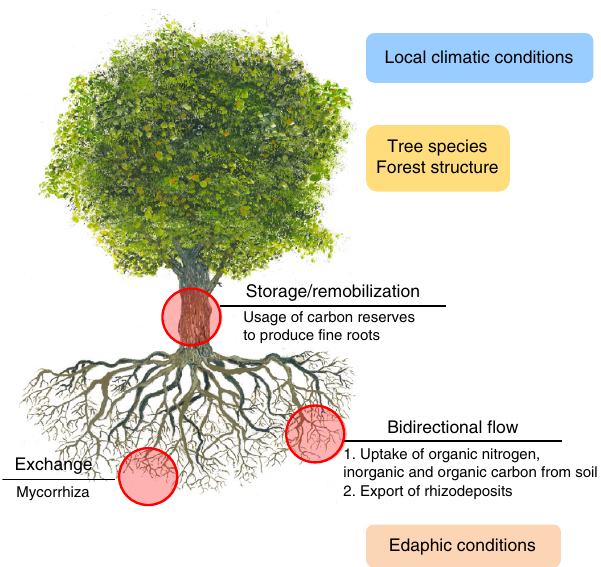
Fig. 4 Summary of possible drivers explaining the difference between the chronological age and the mean radiocarbon age of living fi ne roots. Drivers can be biotic (e.g., forest structure and intrinsic traits of plant species) and abiotic (e.g., climatic conditions and edaphic properties). These factors can alter the amount of old vs new carbon reserves used by trees and